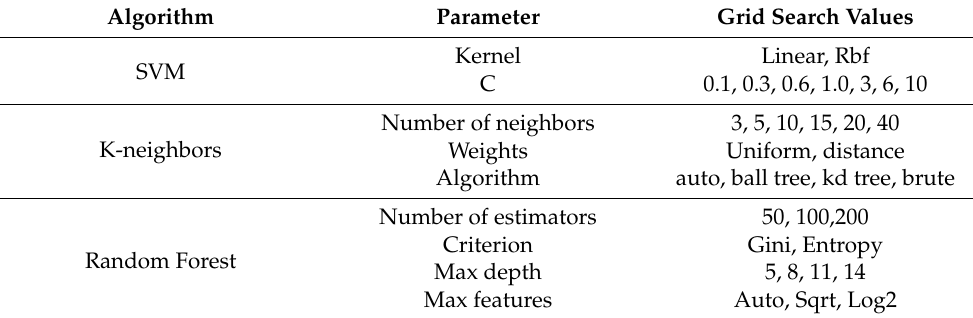
Table 4. Parameters values for tuning ML classifiers.